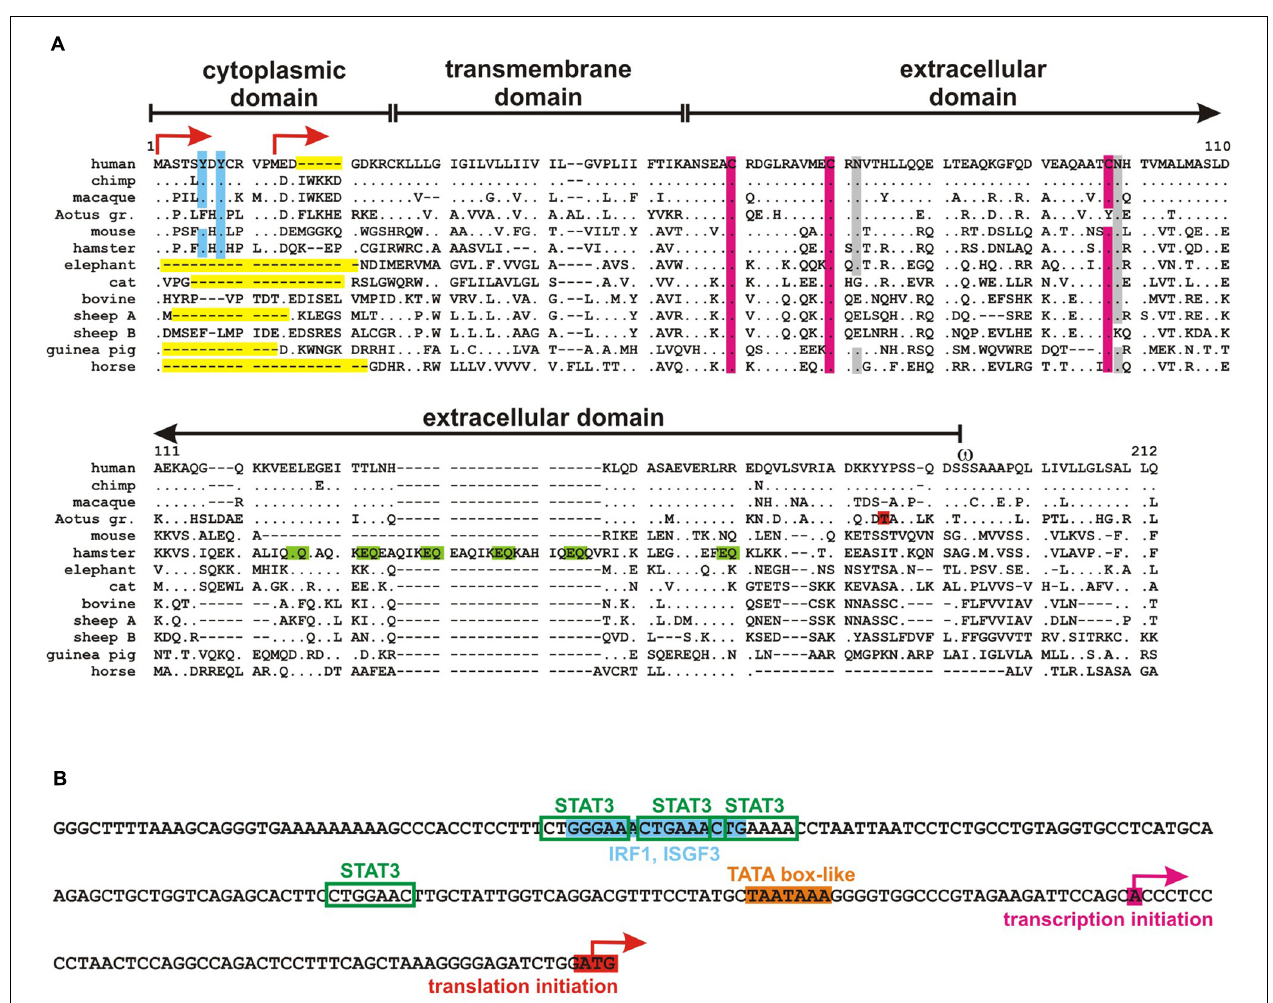
FIGURE 1 |Tetherin sequences. (A) Alignment of tetherin orthologs from different mammalian species. Dots indicate identity and gaps (dashes) were introduced to improve the alignment. Aotus gr. designates the Gray-handed night monkey Aotus griseimembra , sheep A and B the two tetherin proteins encoded by sheeps. A dual tyrosine motif that has been shown to be important for NF- κ B activation as well as RICH2 and adapter protein binding is highlighted in blue, conserved cystein residues that form disulfide bridges are shown in pink and glycosylation sites in gray.Threonine at position 164 of Aotus tetherin is responsible for the lack of virion retention in this species and